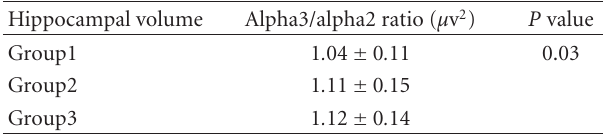
Table 2: Relative alpha3/alpha2 relative power band ratios accord- ing to hippocampal volumes.